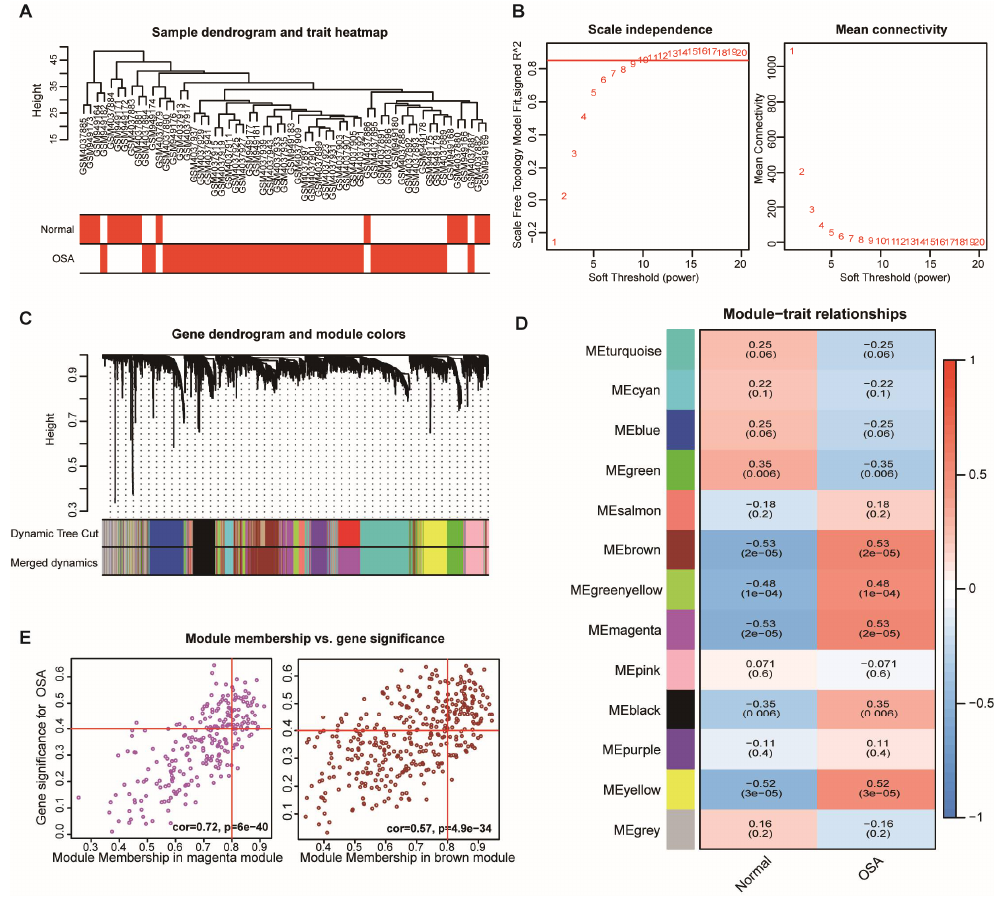
Figure 3. Weighted gene correlation network analysis for the mRNAs. ( A ) The dendrogram of sample and heatmap of the clinical trait. ( B ) Soft threshold powers analysis. The red line corresponds to 0.85. ( C ) Clustering dendrogram of the gene modules. Different colors represent different gene modules, and gray modules are made up of genes that do not belong to any of the modules. ( D ) The relationship between clinical traits and gene modules. Each cells contains the correlation coefficient (upper number) and the corresponding p -value (lower number). ( E ) The scatterplot of gene significance and module memberships in the magenta module (left) and the brown module (right).